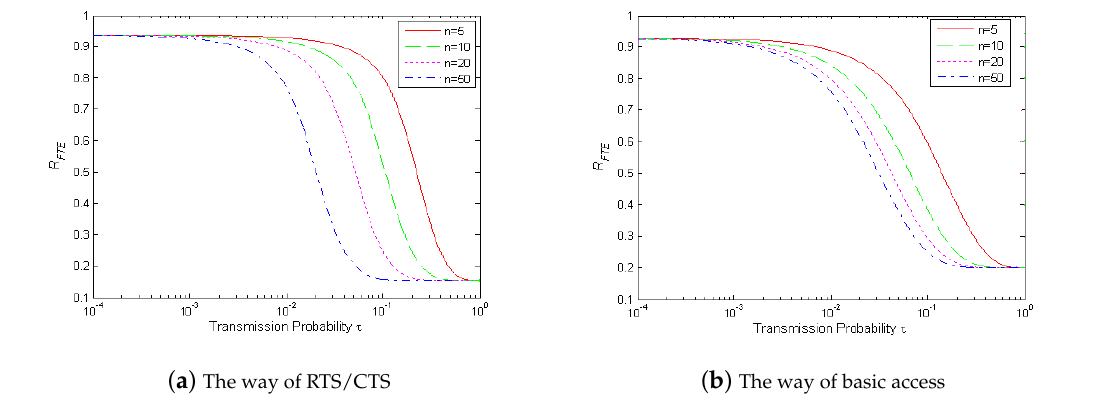
Figure 3. The relation of R FTE , τ and n